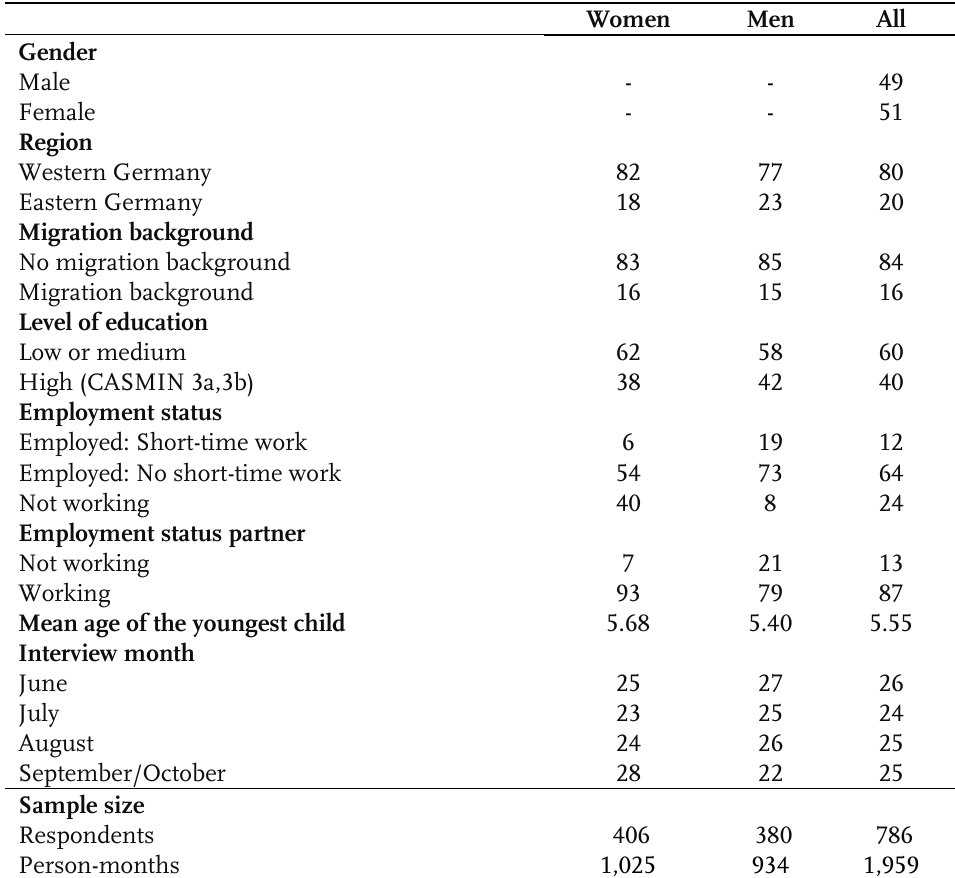
Table 1 : Sample composition, column per cent